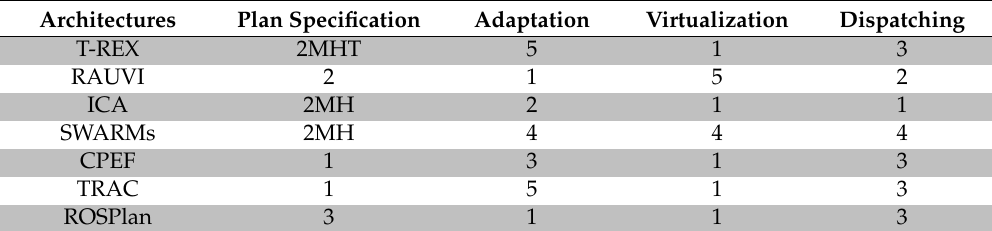
Table 13. Comparisons of categories assigned to the reviewed architectures and